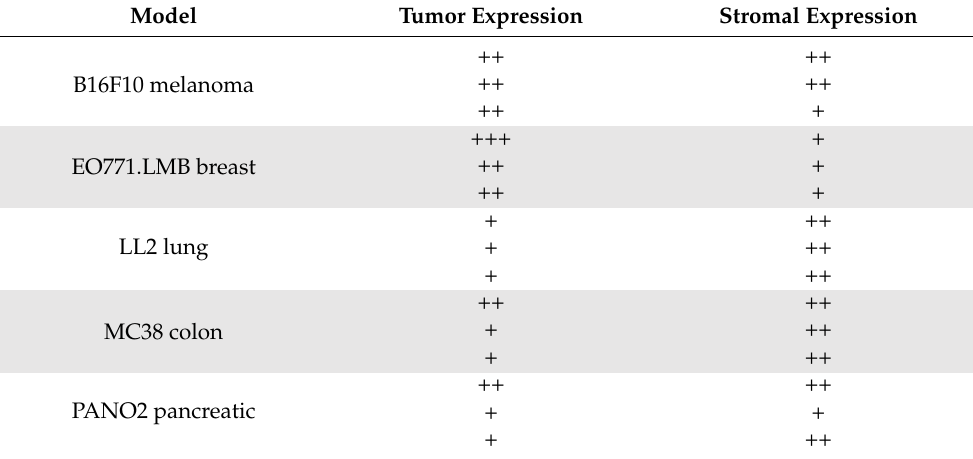
Table 1. Immunohistochemical scoring of YKL-40 protein expression in syngeneic mouse tumors (n = 3 per group). Staining was assessed using a modified Allred scoring based on the sum of a proportion and an intensity score. The Allred scoring was converted to a scale from ‘ − ’ = no expression to ‘+’ = low expression, ‘++’ = moderate expression, and ‘+++’ = high expression. Model Tumor Expression Stromal